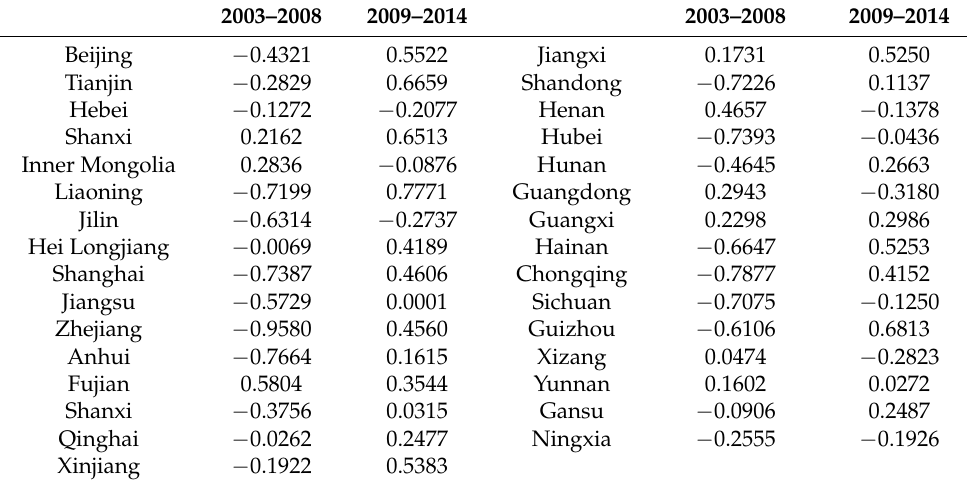
Table 1. Correlations of province-level data.